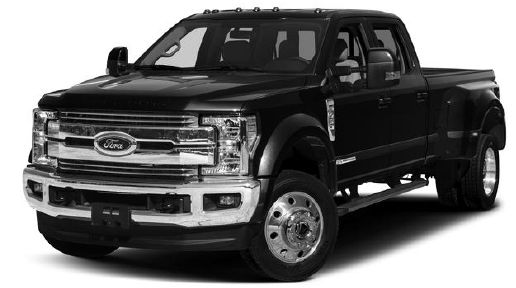
Figure 2. A typical truck.